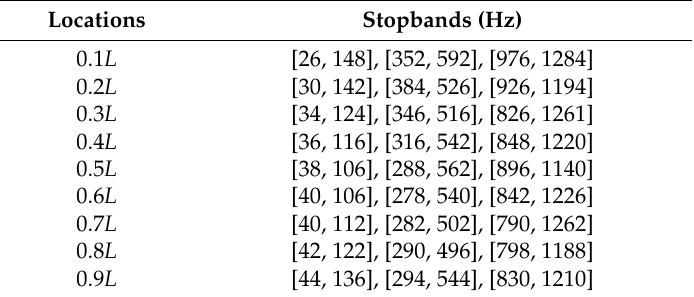
Table 3. Numerical stopbands derived at different crack locations.